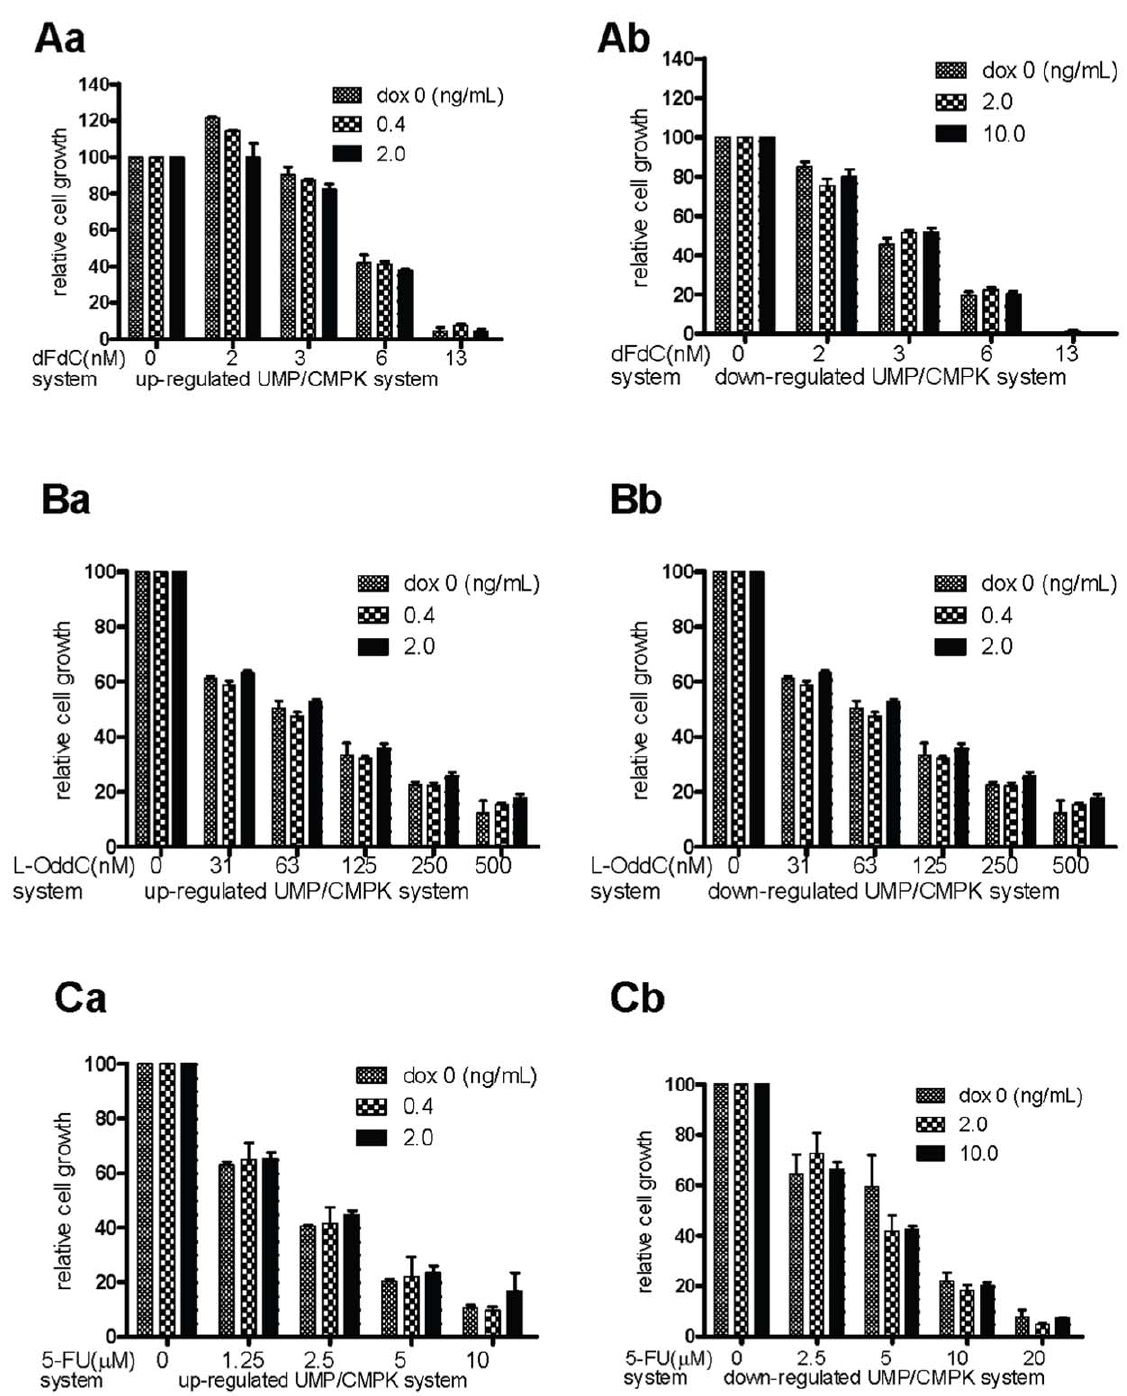
Figure 4. Growth-inhibition activity of deoxycytidine analogs and 5-FU in cells up-regulating or dow-nregulating UMP/CMP kinase expression. Aa,Ba,Ca. growth-inhibition activity of dFdC, L-OddC and 5-FU in cells up-regulating UMP/CMP kinase with different concentration of doxycycline. Ab,Bb,Cb. growth-inhibition activity of dFdC, L-OddC and 5-FU in cells down-regulating UMP/CMP kinase with different concentration of